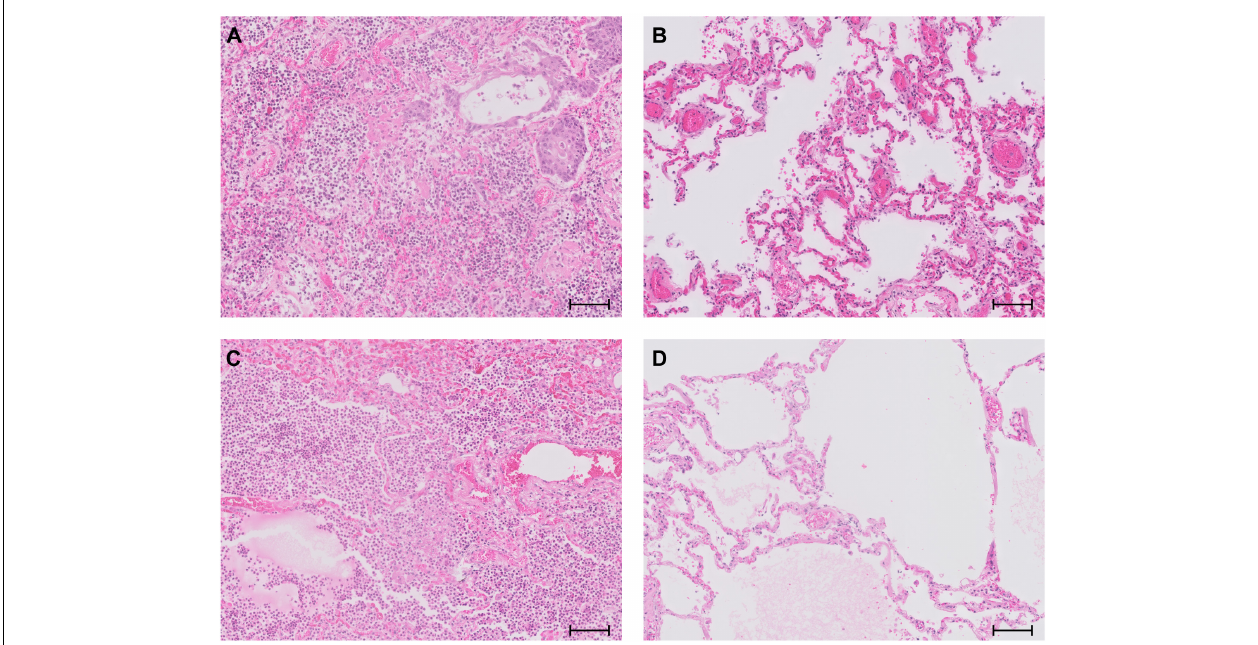
FIGURE 5 | Representative lung histology of (A) a patient with clinically known COVID-19 showing DAD with hyaline membranes, heavy inflammatory infiltration and squamous metaplasia; (B) a patient with clinically known COVID-19 showing only discrete morphological changes in his lungs; (C) a patient who was unexpectedly SARS-CoV-2 positive post mortem with bacterial co-infection and signs of acute bronchopneumonia; (D) a patient who was unexpectedly SARS-CoV-2 positive post mortem with emphysema and discrete edema, but no relevant inflammation. Scale bar, 100 µ m.